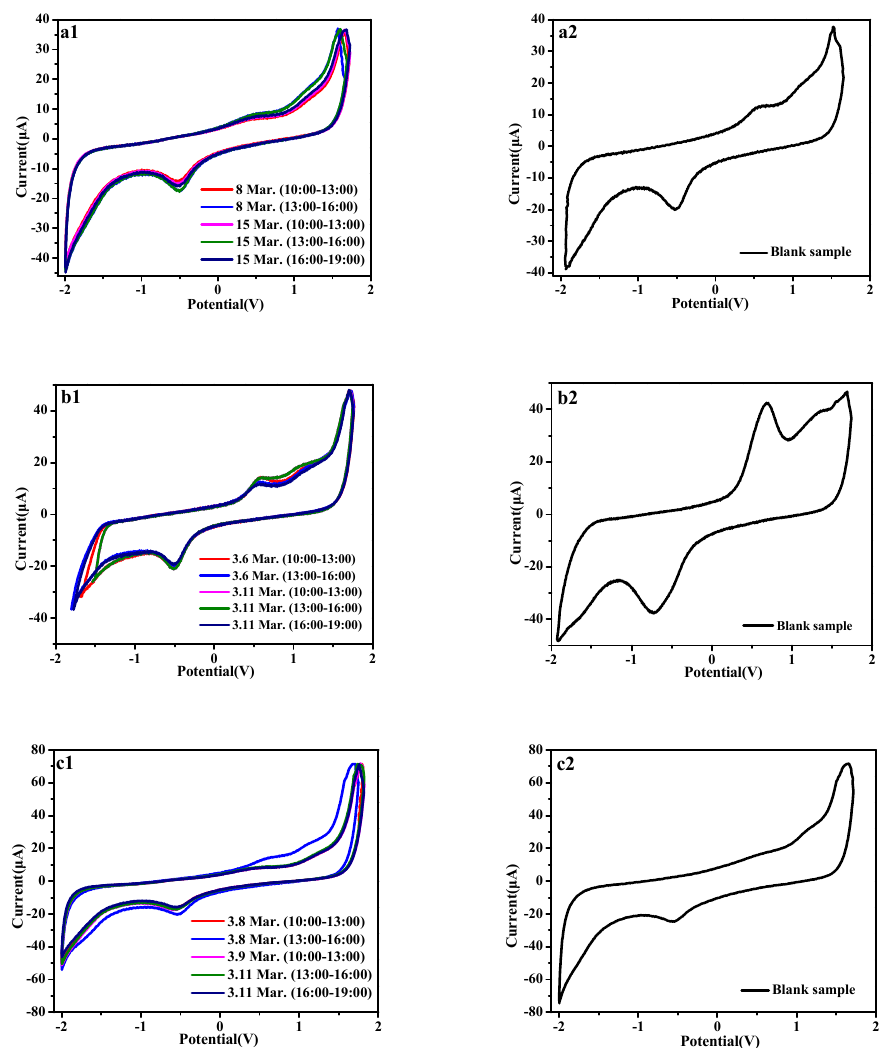
Figure 8. ( a ) CV curves for quercetin after and before sampling at a scan rate of 50 mv/s; ( b ) CV curves for glycyrrhizic after and before sampling at a scan rate of 70 mv/s; ( c ) CV curves for α - mangostin after and before sampling at a scan rate of 100